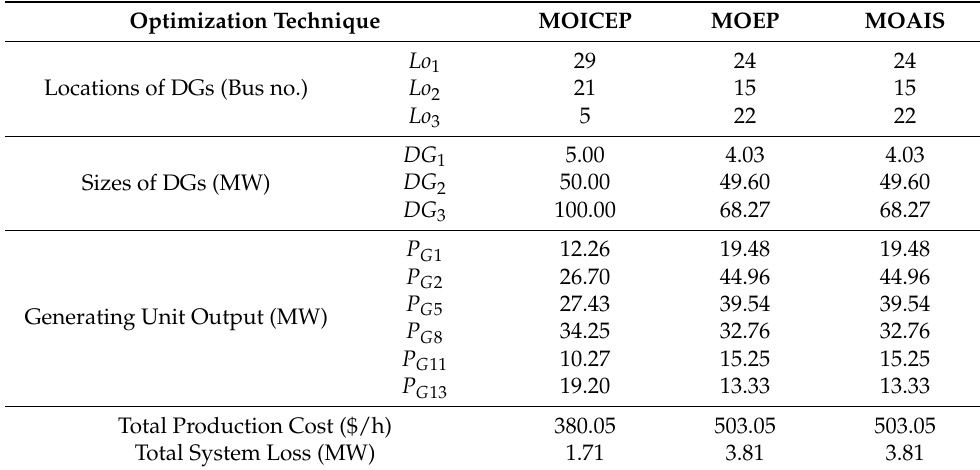
Table 10. Results of the integrated ED problem with prohibited operating zones and DG installation of the IEEE 30-Bus RTS ( w 1 = 0.9 and w 2 = 0.1). Optimization Technique MOICEP MOEP MOAIS Locations of DGs (Bus no.)